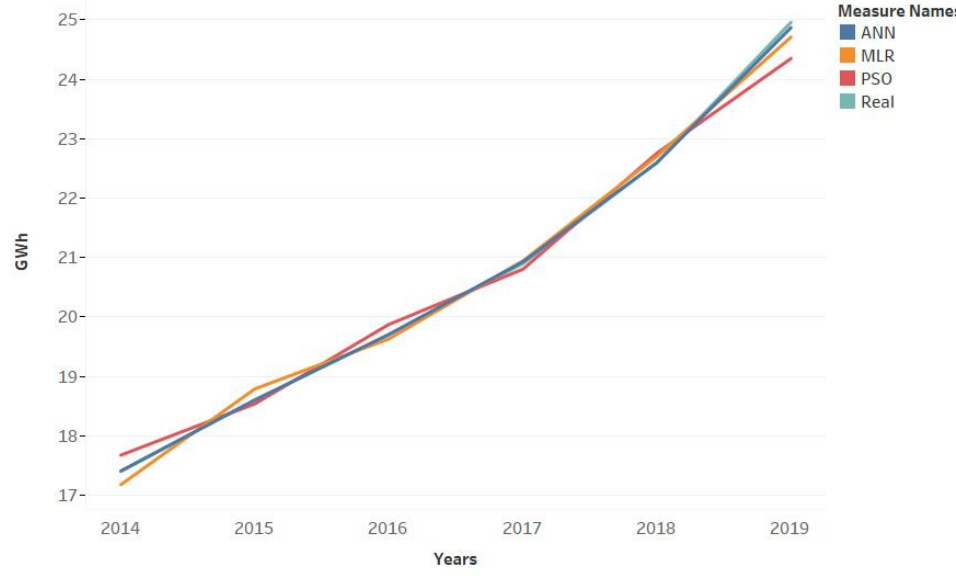
Figure 12. Gokceada Island real electricity energy demand compared to that of the methods.